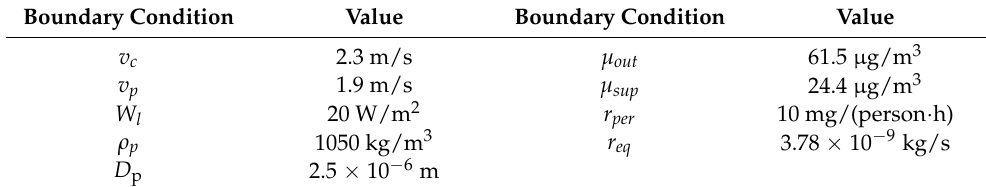
Table 3. Boundary conditions for the CFD model. Boundary Condition